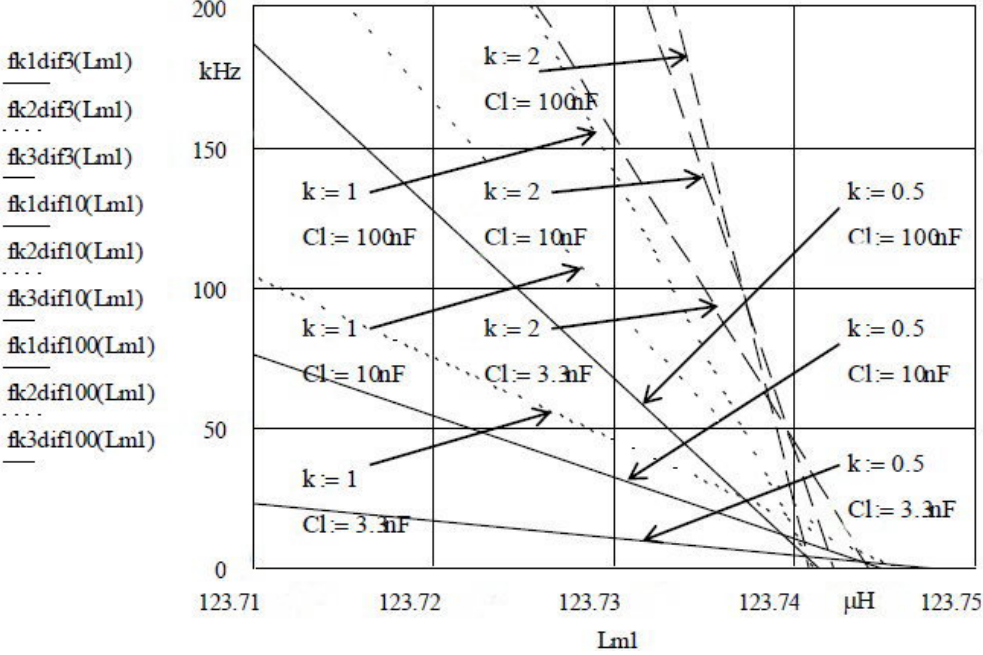
and different C m1 L